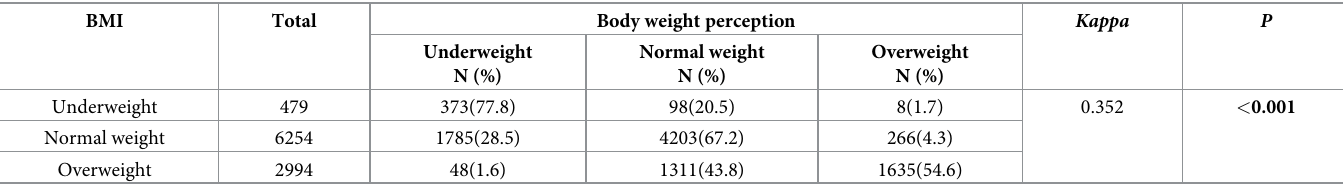
Table 4. Consistency analysis of BMI and body weight perception a